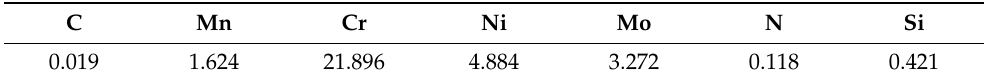
Table 1. Steel composition in weight percent, measured by spectral analysis.